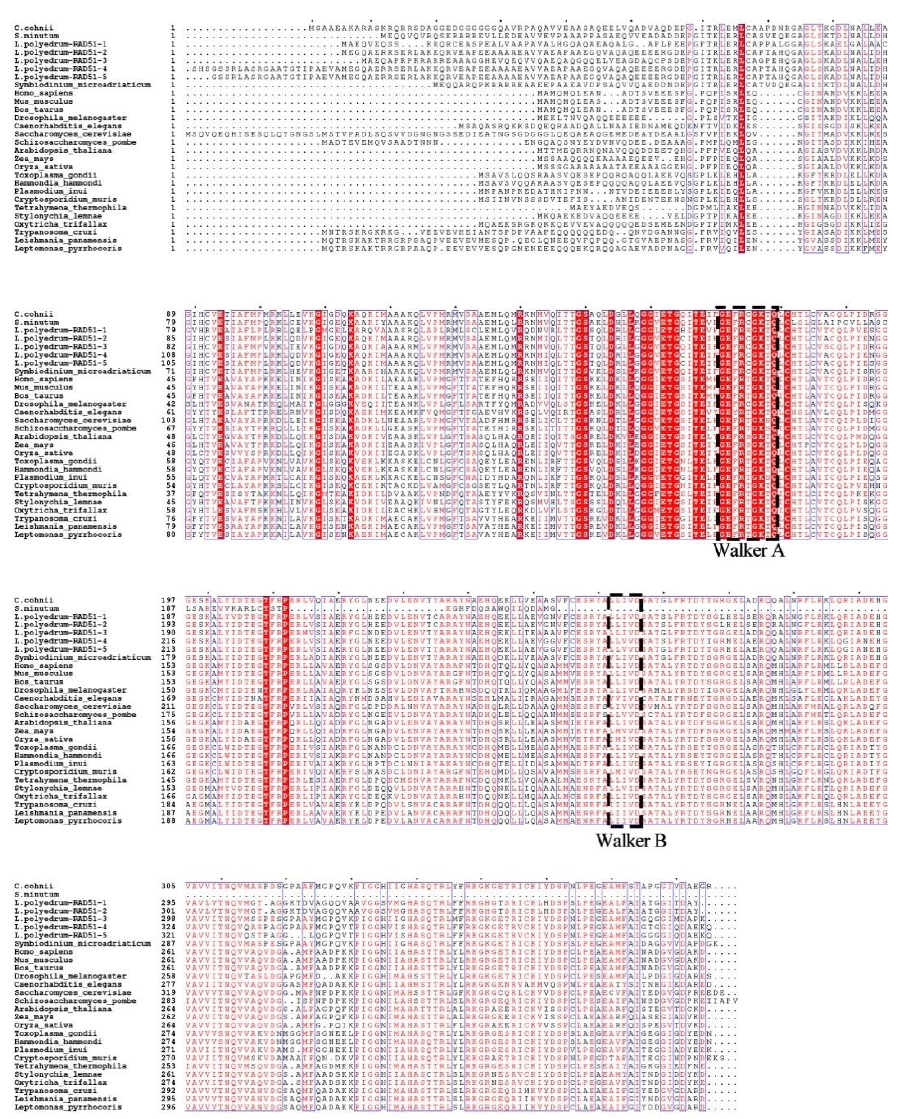
Figure 6. Multi-alignment of dinoflagellate RAD51 proteins.